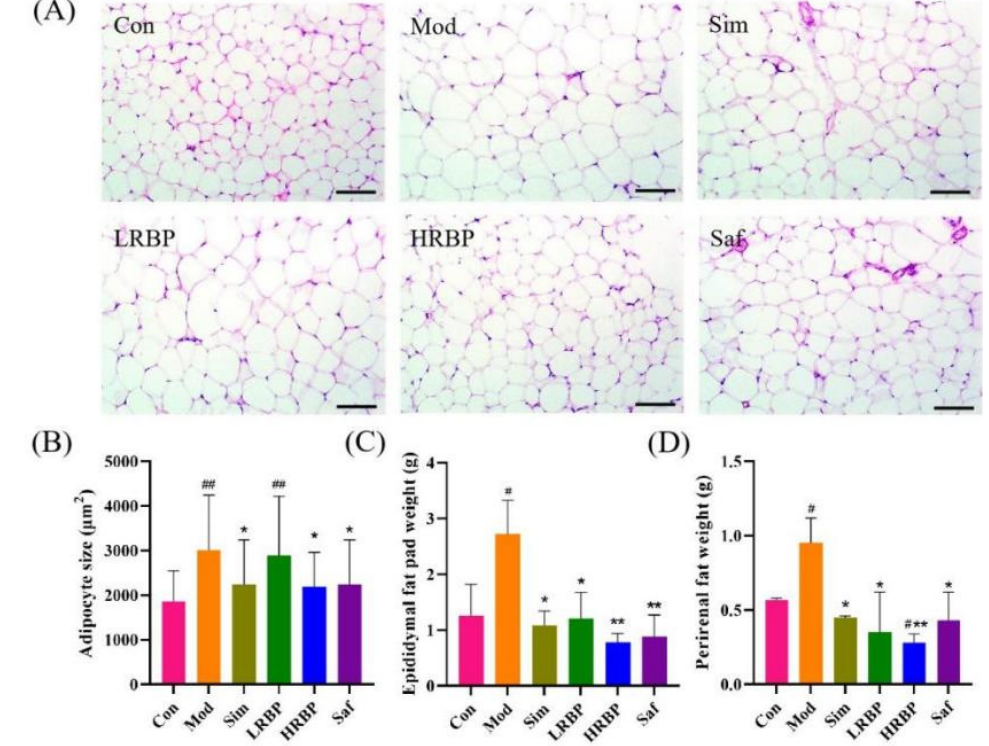
Figure 2. Effect of RBPs on adipose tissue in HFD-fed mice. ( A ) The results of HE staining of epi-